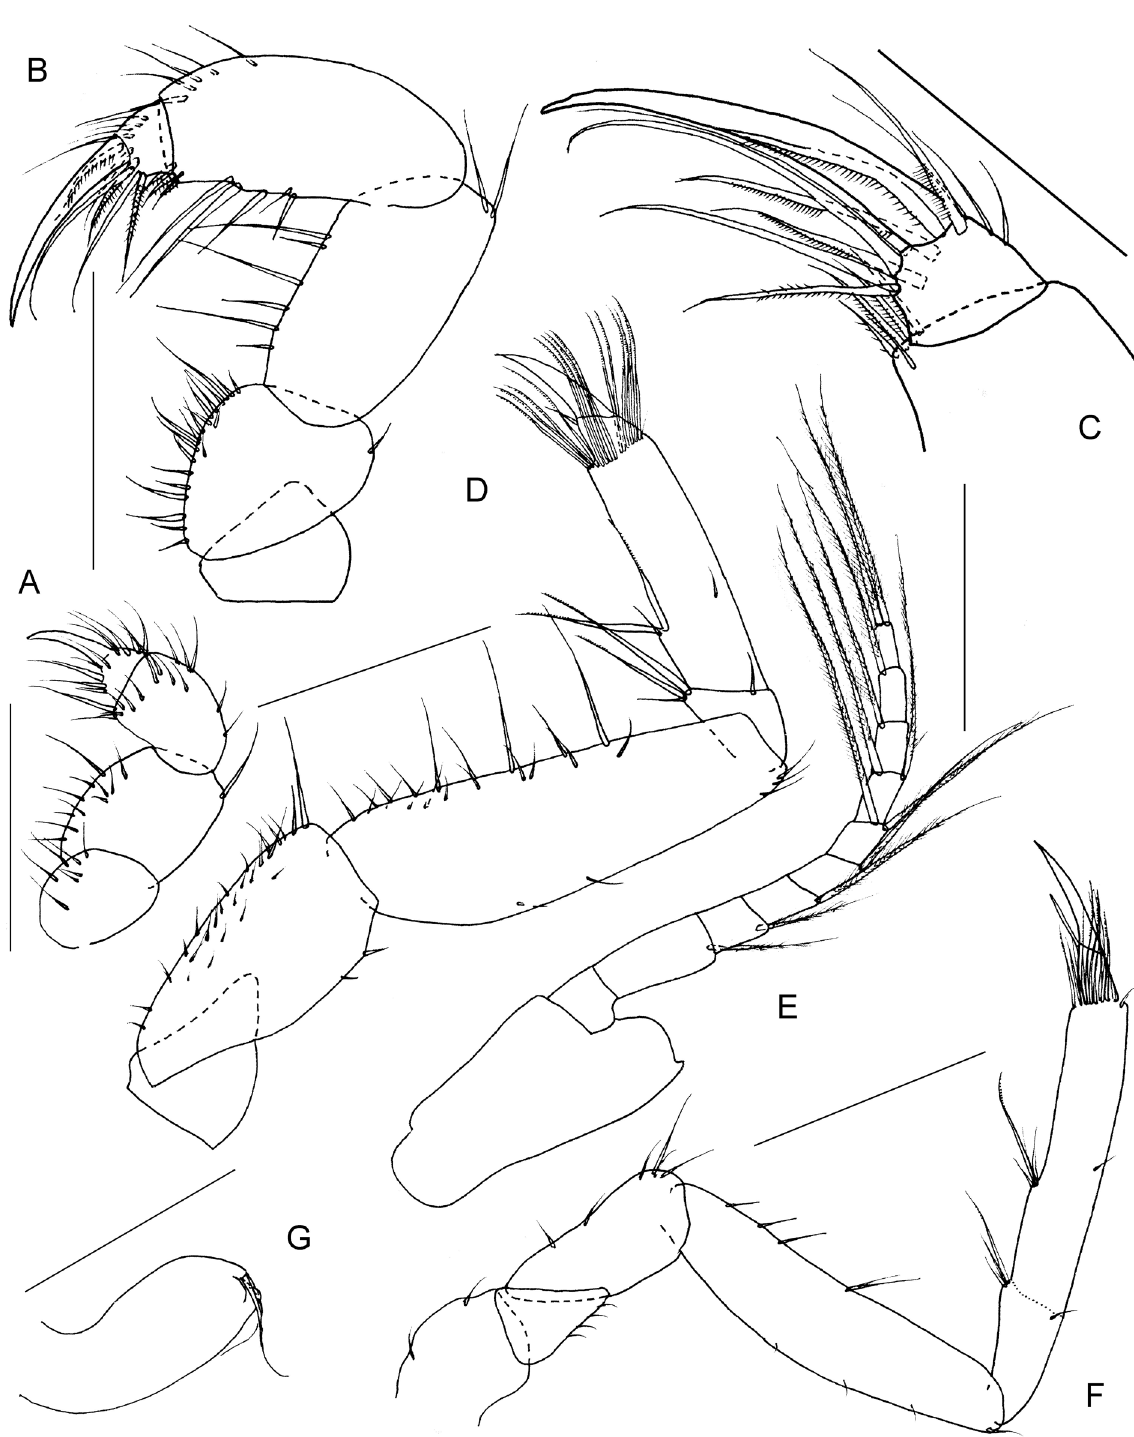
Fig. 19. Siriella occulta sp. nov., holotype, ♂, length 6.5 mm, Arabian Gulf, Saudi Arabia. A . Maxilliped 1, anterior view. B . Maxilliped 2, anterior view. C . Dactylus of maxilliped 2, anterior view. D . Endopod of pereopod 1, anterior view. E . Exopod of pereopod 1. F . Endopod of pereopod 6, anterior view. G . Penis. Scale bars: A–B, D–G = 0.25 mm; C = 0.1